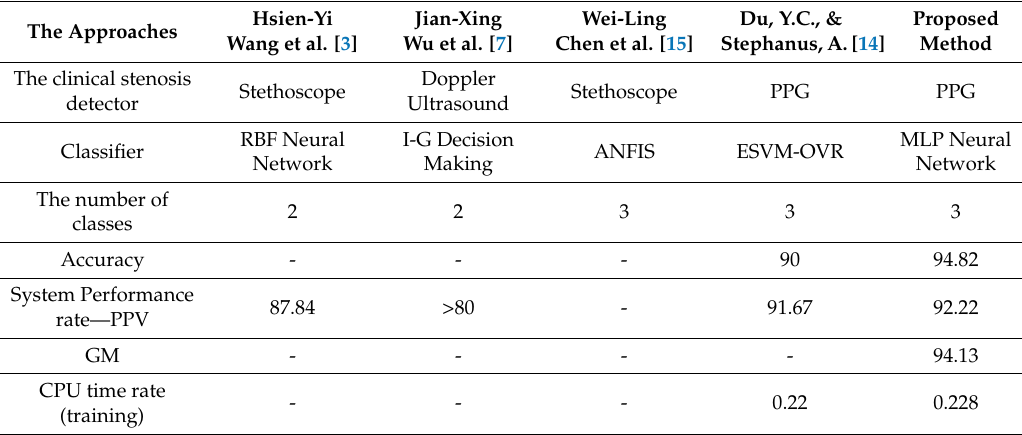
Table 9. Comparative Table of Similar Research.